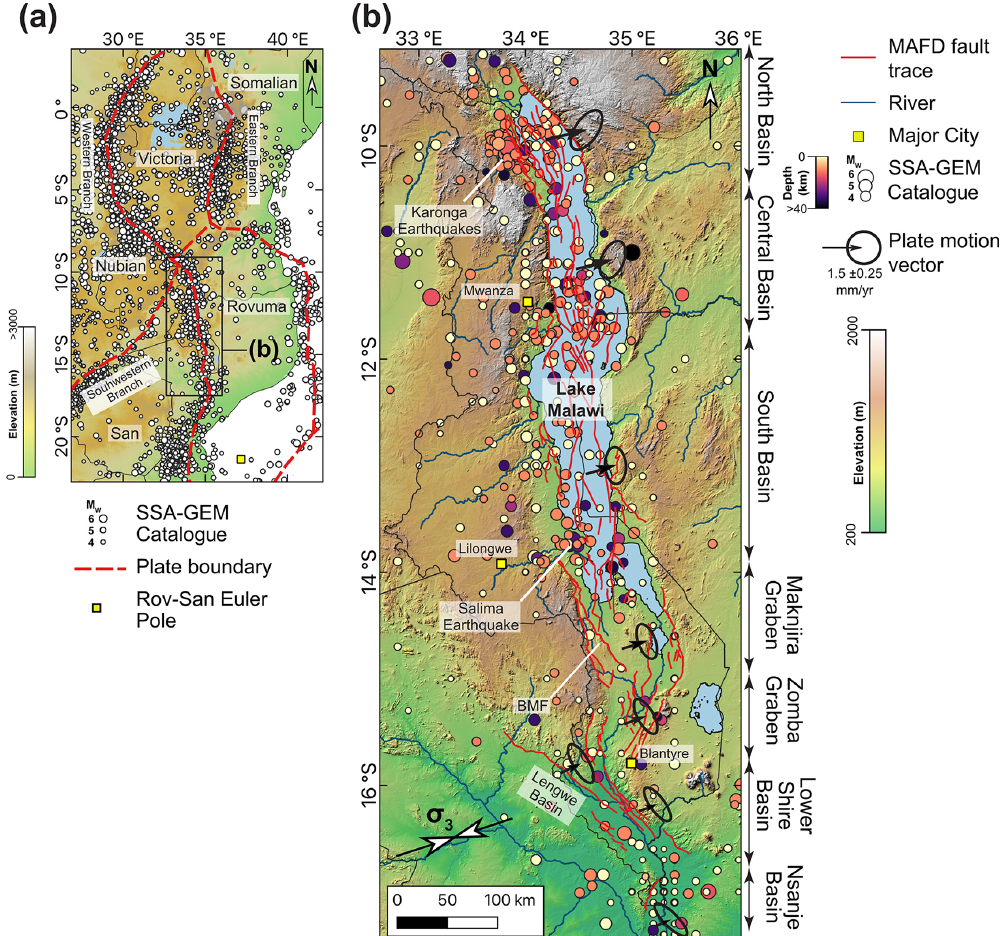
Figure 1. (a) Location of Malawi within the context of an East-African-Rift-scale geodetic model (Wedmore et al., 2021) and earthquake locations from the Sub-Saharan Africa Global Earthquake Model catalogue (SSA-GEM; Poggi et al., 2017). (b) The Malawi Active Fault Database (MAFD) and major EAR basins in Malawi (Williams et al., 2022b). Plate motion vector describing the motion of the Rovuma Plate relative to a fixed San Plate for the central point of each basin is also shown (Wedmore et al., 2021), with the error ellipse modelled using the methods described in Robertson et al. (2016). Figures underlain by (a) 90m resolution Global 30 Arc-Second Elevation (GTOPO30) digital elevation model (DEM) and (b) Shuttle Radar Topography Mission (SRTM 30m DEM; Sandwell et al., 2011). σ 3 denotes trend of the minimum principal compressive stress in Malawi (Williams et al., 2019). Note: BMF is the Bilila–Mtakataka